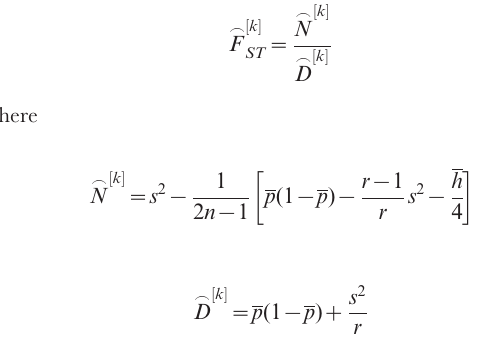
Figure S1 Effect of increasing sample sizes and increas- ing marker numbers with uniform allele